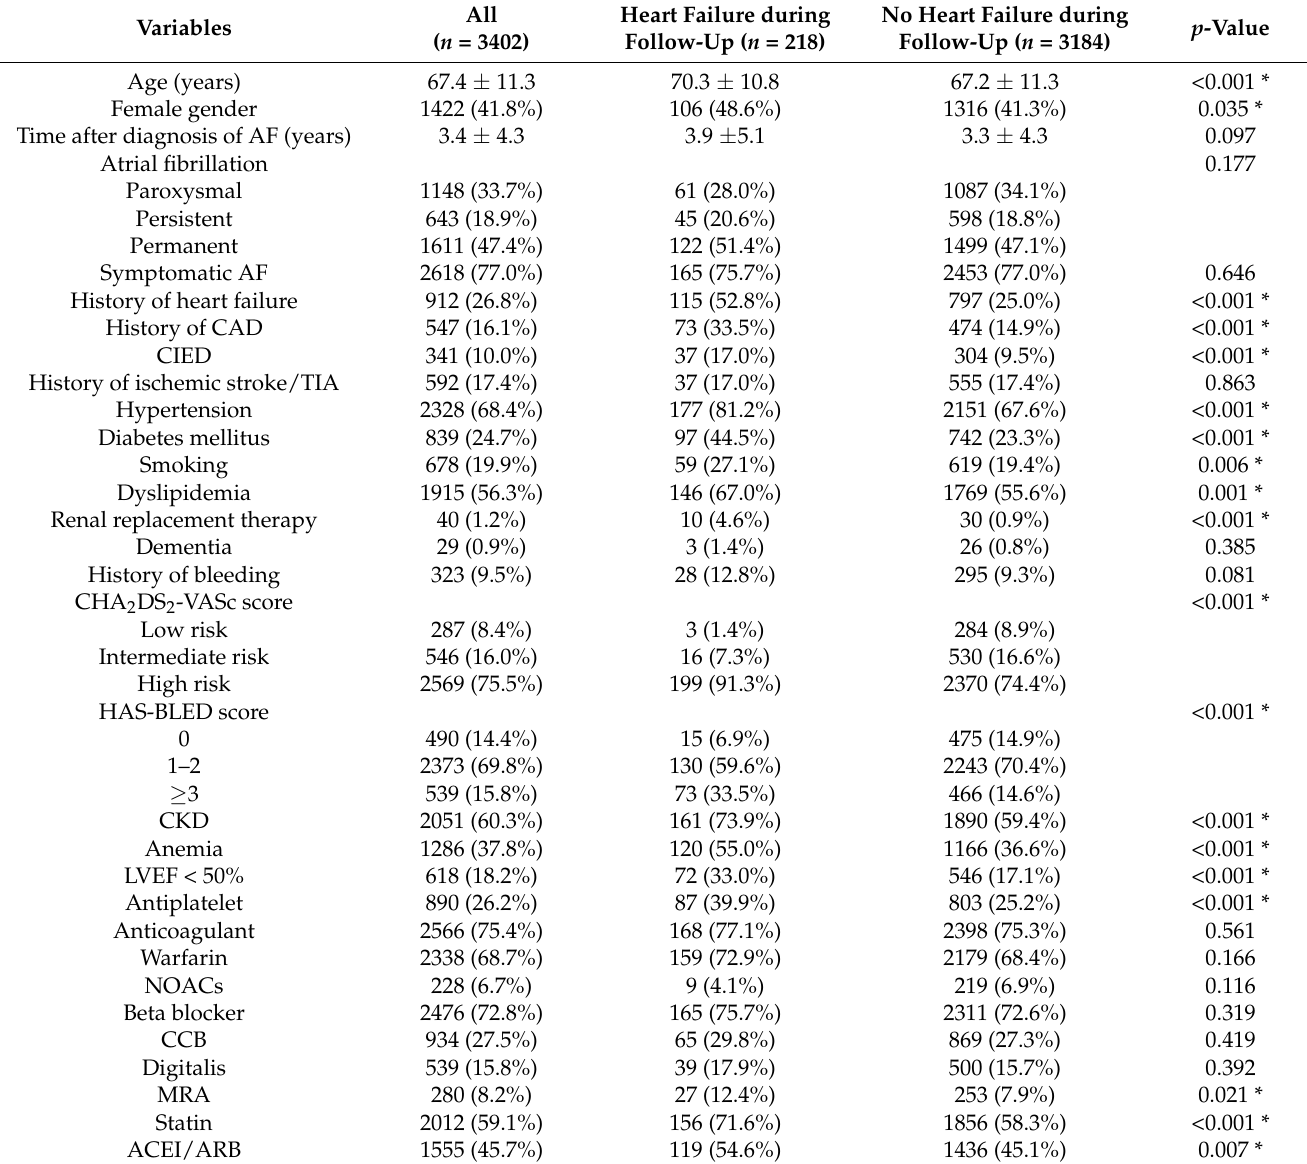
Table 1. Baseline characteristics of patients with and without heart failure during